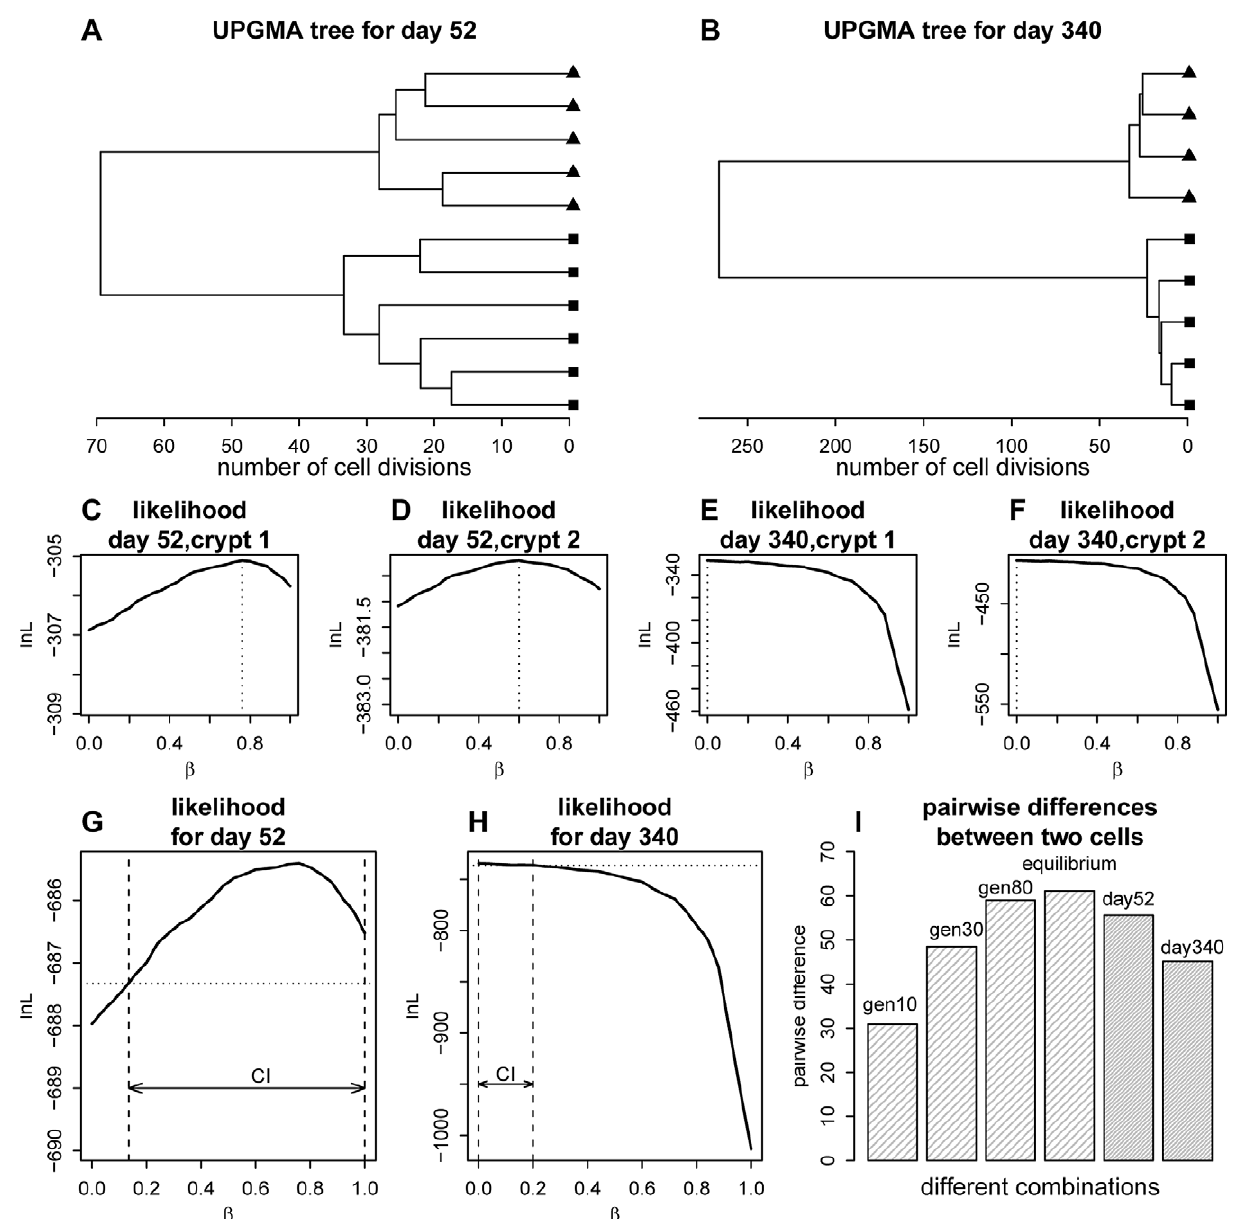
Figure 2. Phylogenetic relationships for the crypt single cells and likelihood curve for the proportion of asymmetric divisions. (A) Unweighted Pair Group Method with Arithmetic mean(UPGMA) tree [66] for the cells sampled from the two crypts at day 52. Distances were calculated using the two-step mutation model. (B) UPGMA tree for day 340. (C) Likelihood curve as a function of the proportion of asymmetric divisions for one of the crypts at day 52. (D) The same plot as panel C, but for the other crypt at day 52. (E) Likelihood curve as a function of the proportion of asymmetric divisions for one of the crypt at day 340. (F) The same plot as panel E, but for the other crypt at day 340. (G) Likelihood curve as a function of the proportion of asymmetric divisions for day 52 (combining two crypts). The horizontal dashed line marks the level of likelihood that is 1.92 units (0.5 6 x 2 (0 : 95) ) below the maximal value. The confidence interval (CI) for the proportion of asymmetric division rate is df ~ 1 shown as the arrow between the two vertical dashed lines. (H). Likelihood curve as a function of the proportion of asymmetric divisions for day 340 (combining two crypts). The horizontal dashed line marks the level of likelihood that is 1.92 units below the maximal value. The confidence interval (CI) for the proportion of asymmetric division rate is shown as the arrow between the two vertical dashed lines. (I) A demonstration of the phenomena that the gene tree will increase in size as the crypt population reaches equilibrium (stationarity). The genealogical tree size (indicated as the mean pairwise divergence for two randomly picked cells) at different cell generation (generation 10, 30, 80 as well as equilibrium point) for the crypt population are shown ( b =0.4). The observed pairwise divergence for day 52 and day 340 are also plotted.